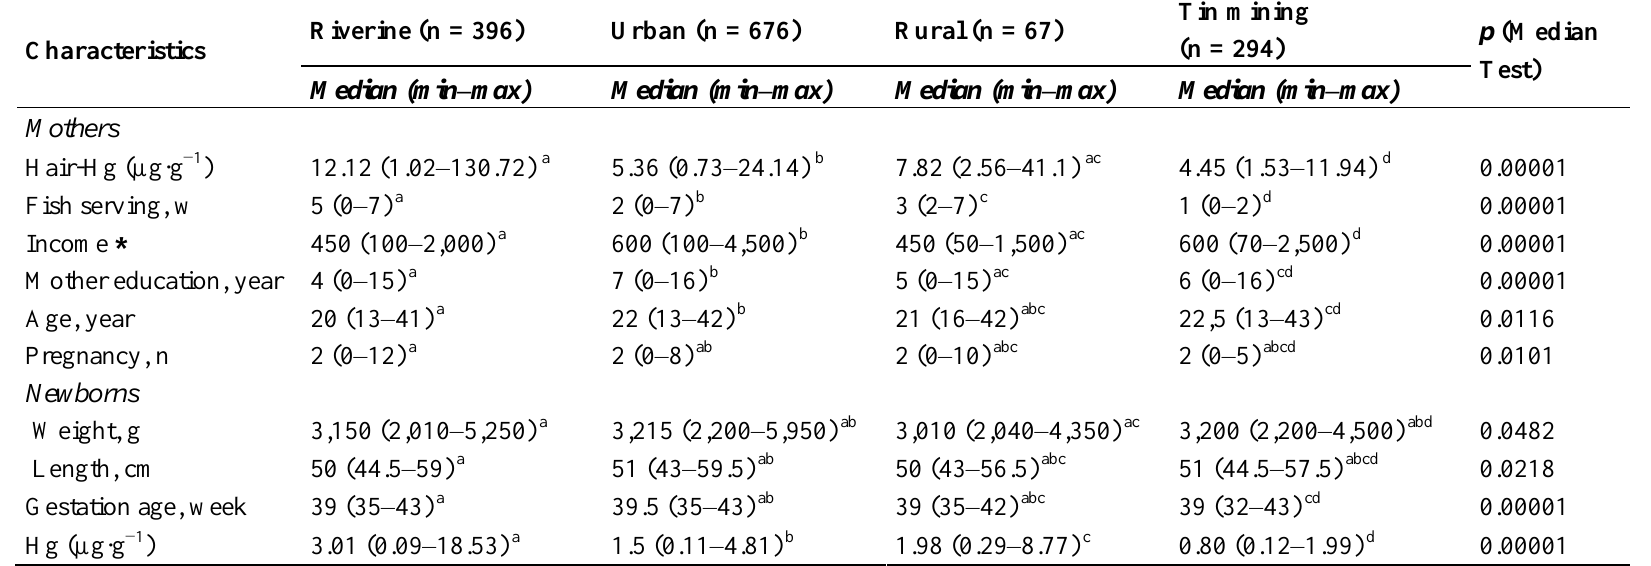
Table 1. Summary of maternal constitutional (age, gestational age, and number of pregnancies) and environmental (family income, number of school years, hair-Hg concentrations) mother-newborn (anthropometry, hair-Hg concentrations) pairs of low-socioeconomic families inhabiting the Madeira River